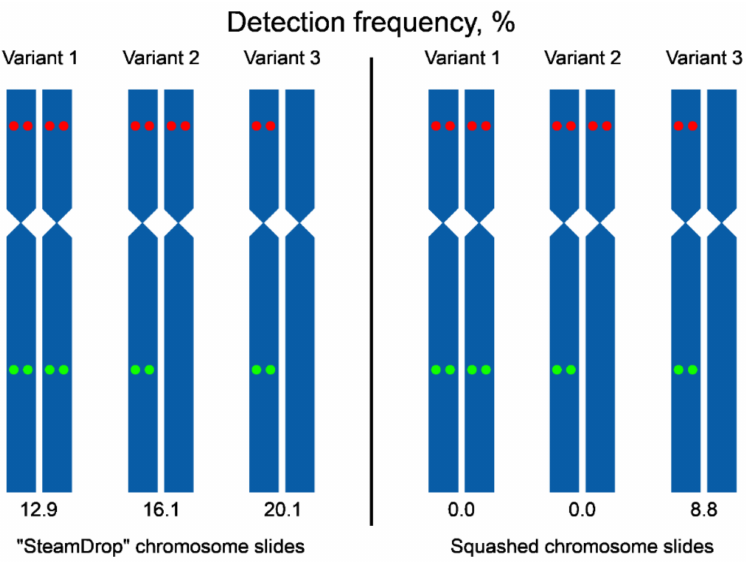
Figure 8. Scheme of variants of a signal detection on a pair of homologous chromosomes 2 us- ing chromosome preparations obtained by “SteamDrop” and squashed methods. The green dots– Unigene5305, the red